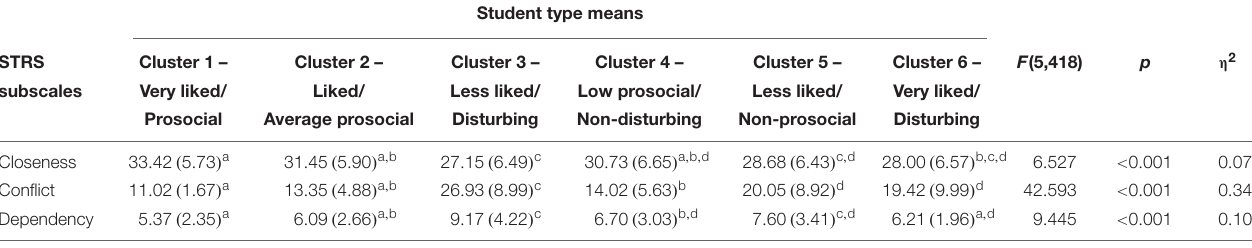
TABLE 3 | Typology and STRS subscales: Descriptive statistics, univariate ANOVA tests, pairwise comparisons and partial eta-squared.